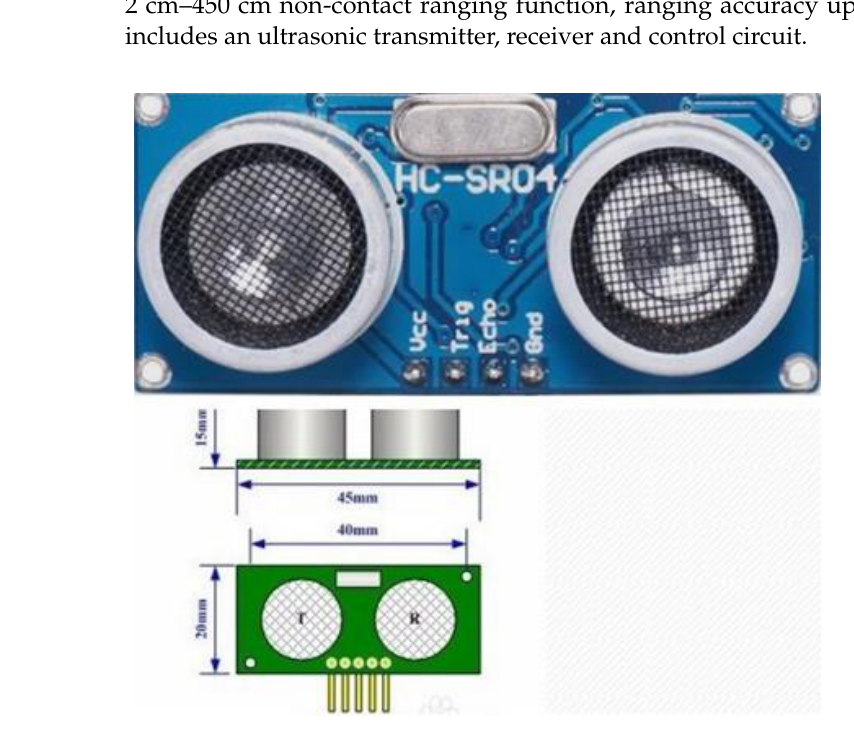
Figure 10. Ultrasonic